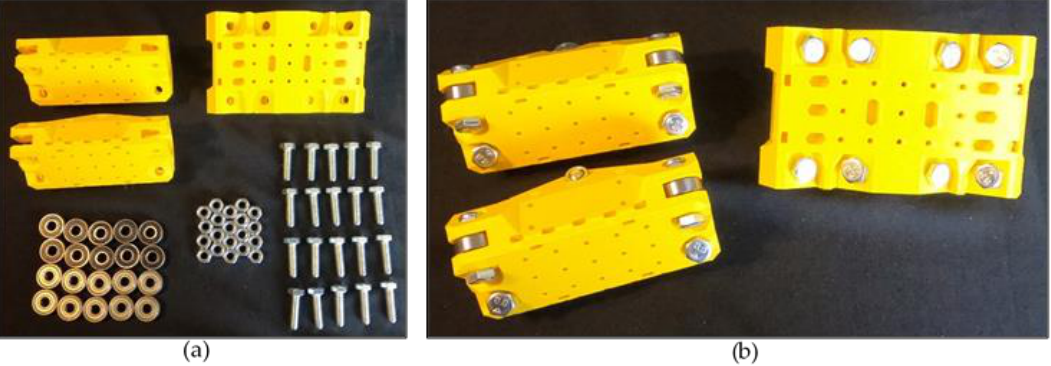
Figure 2. ( a ) X -axis and Y -axis sliders with all the bearings, bolts, and locknuts; ( b ) X -axis and Y -axis sliders with bearings installed.